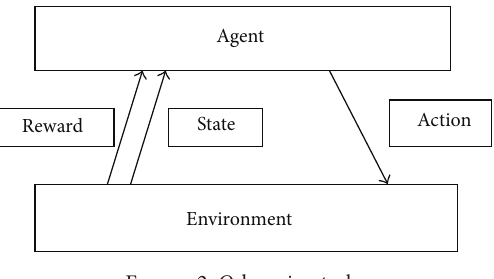
Figure 2: Q -learning